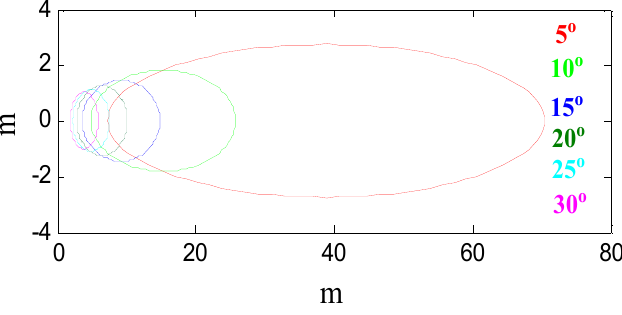
Figure 13. The First Fresnel zone for a typical 2 m antenna height with different elevation angles.